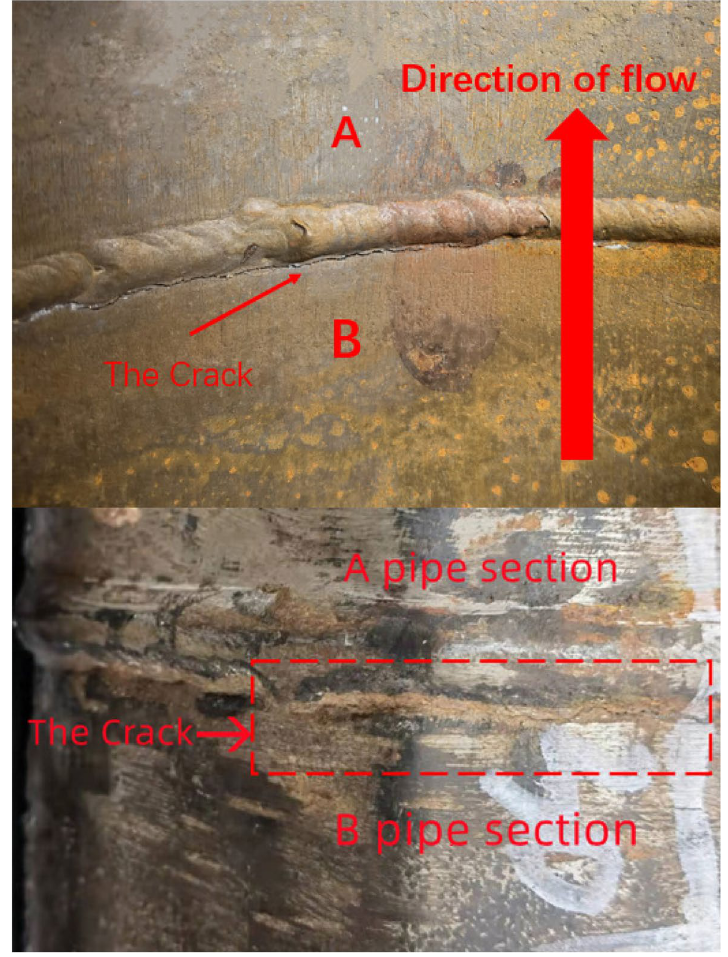
Fig. 2 Macroscopic appearance of pipeline weld position